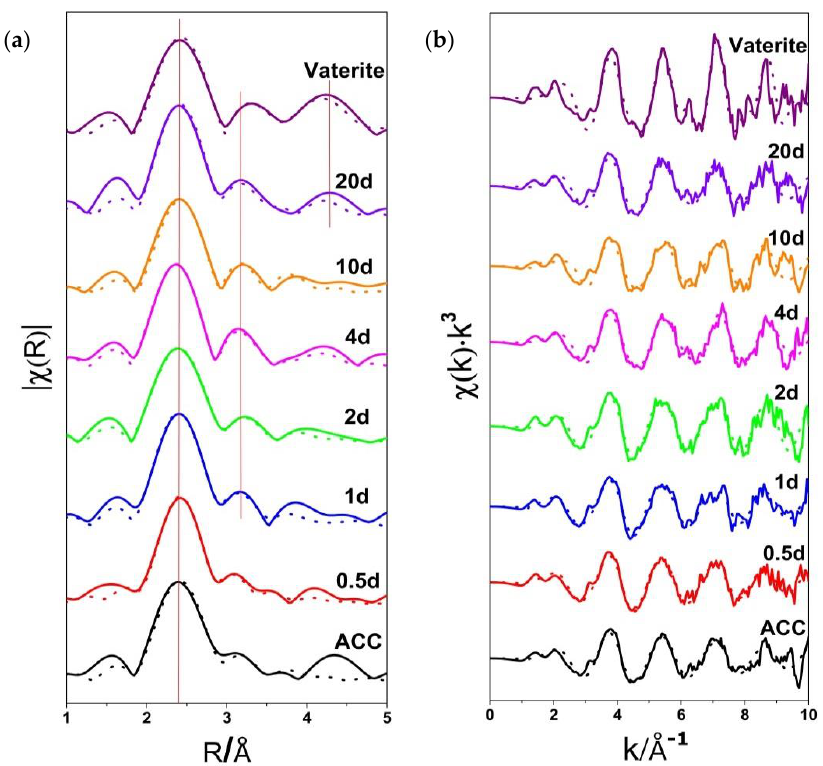
Figure 2. Ca K-edge extended X-ray absorption fine structure (EXAFS) spectra of experimental data (solid line) and the fitting results (dotted line) for proto-vaterite ACC and samples crystallized for different times and well-crystalline vaterite reference plotted in R space (Fourier transform magnitude) ( a ) and k space ( b ). The relative intensities of the χ(R) and χ(k)·k 3 were shown in Figure 2.